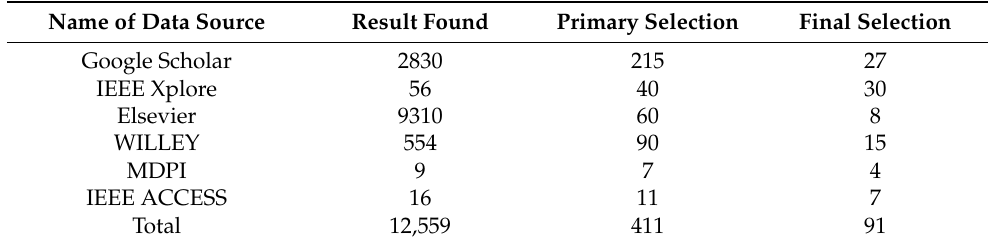
Table 1. Data sources and search